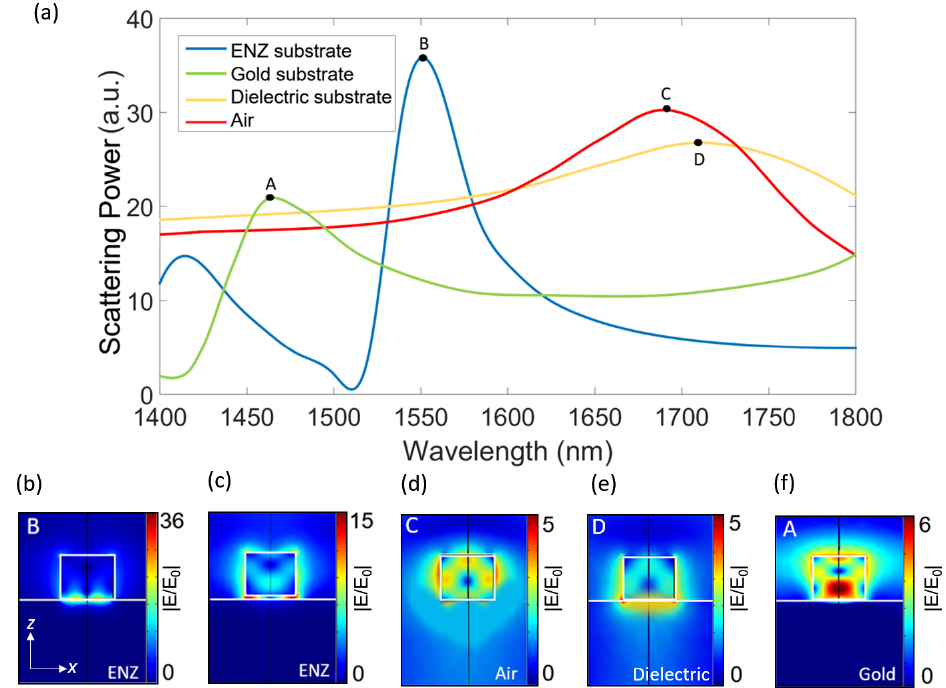
Figure 4. ( a ) Scattering spectra for an AlGaAs nanocylinder with r = 232 nm and h = 400 nm placed over the different substrates. ( b ) Near-field distributions of the electric field enhancement for nanodisk placed over the ENZ substrate at the pump wavelength of 1550 nm and ( c ) with a gap from the substrate equal to 30 nm. ( d ) Near-field distribution for the same AlGaAs nanoantenna completely surrounded by air at 1694 nm; in the case of dielectric substrate ( d ) at 1710 nm and in the case of gold substrate ( e ) at 1460 nm.